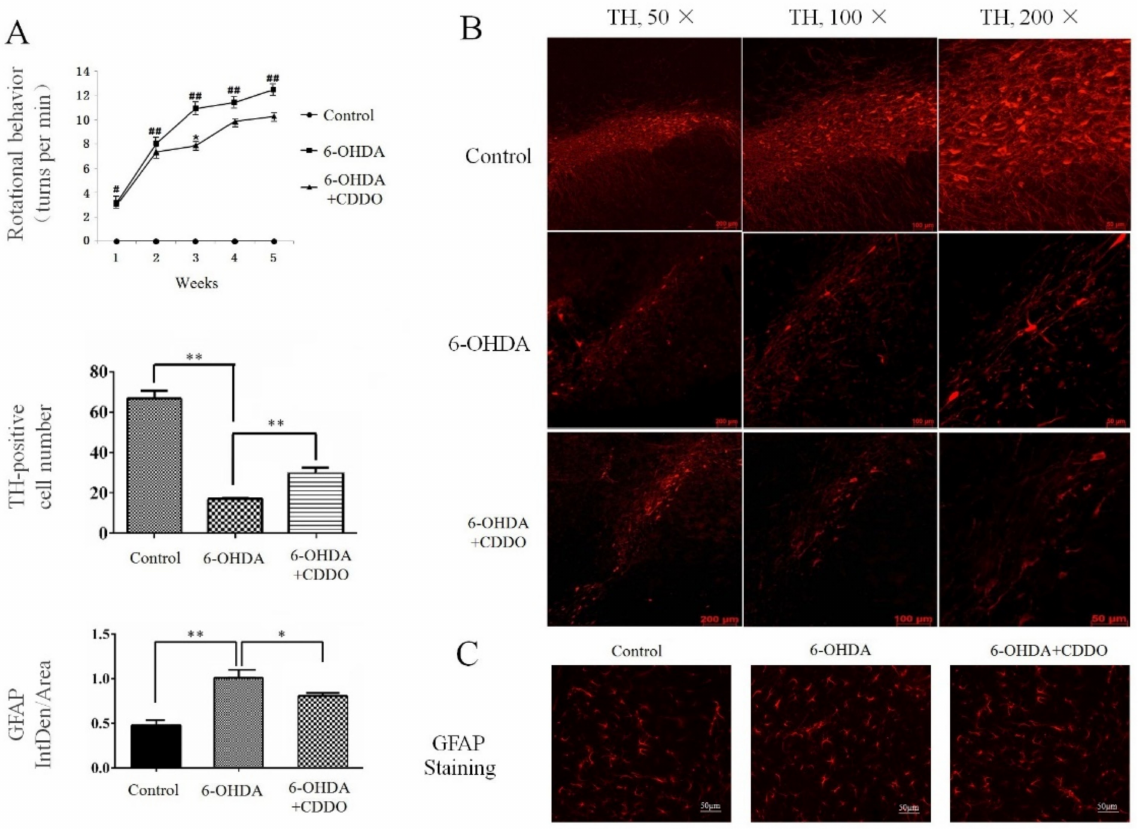
Figure 1. CDDO-Me improved 6-OHDA-induced PD-like phenotypes in rats. ( A ) Apomorphine-induced contralateral rotation assays. The number of contralateral rotations significantly increased in 6-OHDA rats compared with that in the control group ( # p < 0.05, ## p < 0.01, n = 5, compared with the control group). The rotation behavior appeared in first week after 6-OHDA injection (average rotation score was 3.13 ± 0.62 r/min, # p < 0.05, n = 5, compared with the control